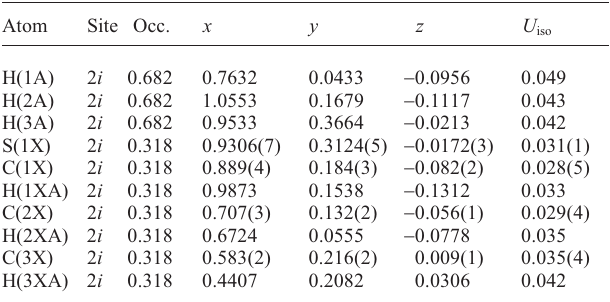
Table 2. Atomic coordinates and displacement parameters (in Å 2 )